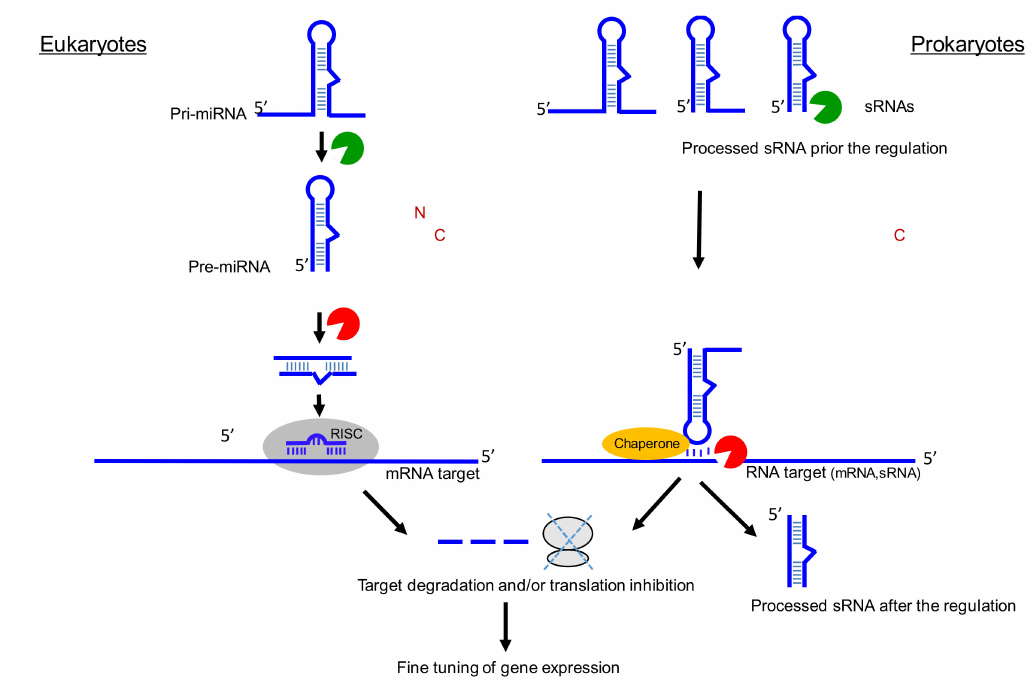
Figure 2. Parallels between miRNA and sRNA biogenesis and functions. For miRNA, two enzymes (Drosha and Dicer) are usually required for the biogenesis of a double strand RNA. Only one RNA strand is associated with argonaute protein. The RISC (RNA-induced silencing complex) allows the base pairing with the target (here mRNA) and the recruitment of other proteins involved in translation inhibition and mRNA decay. ‘N’ for nucleus and ‘C’ for cytosol. For sRNA, various RNases (green) can cleave triphosphorylated primary transcripts, and each matured RNA can hold their own functions in stress, metabolism, or virulence. Base-pairing with the target(s) (here mRNA) can be facilitated by dedicated chaperones (orange) than can be followed by target RNA cleavage (red) and/or by modifying translation initiation onto the target mRNA. Both miRNA and sRNA fine-tune gene expression. Note that the sRNA processing steps are not well-examined in many cases and can occur either prior and/or after binding onto their RNA